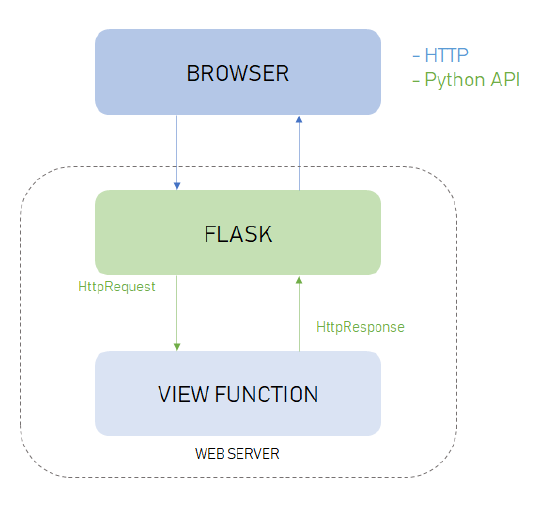
Figure 2. Software architecture.